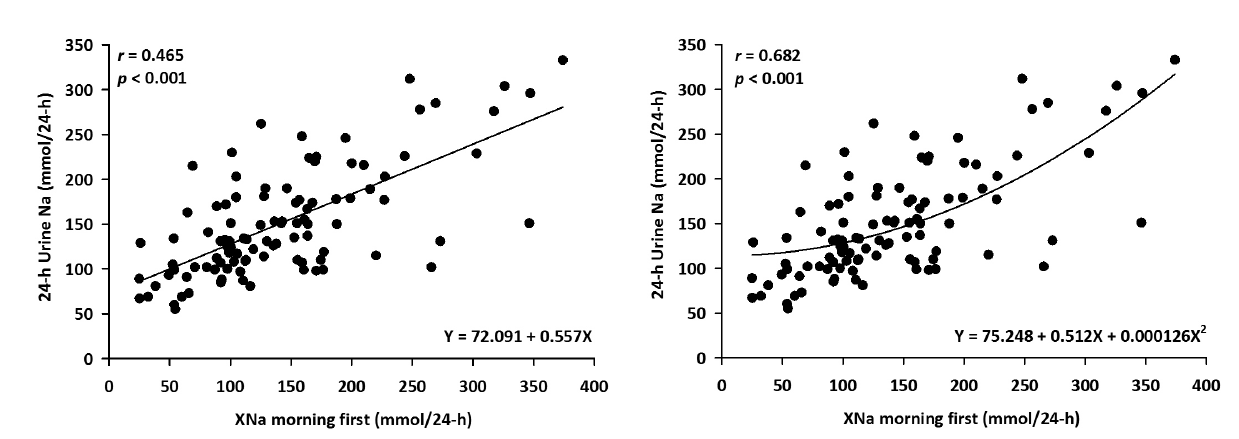
Figure 2. Development of equations by curve fitting from 101 subjects. ( a ) Linear equation association; ( b ) quadratic equation association and ( c ) cubic equation